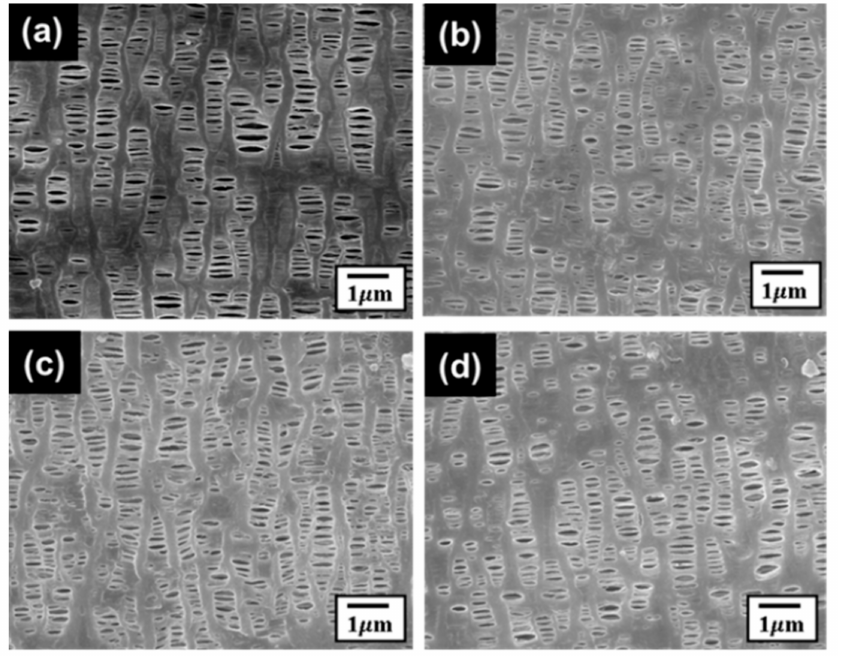
Figure 9. FE-SEM images of the separators under different conditions: ( a ) pristine in a fresh cell, ( b ) after the cycling test, ( c ) immediately after the fatigue test, and ( d ) after the fatigue and cycling test.